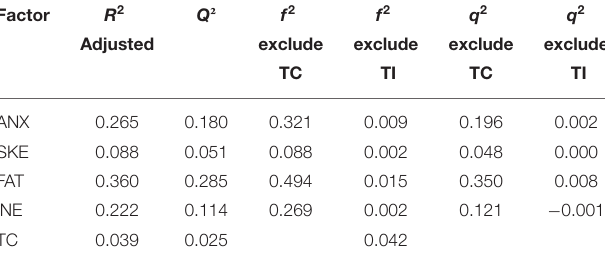
TABLE 7 | Power and predictive relevance